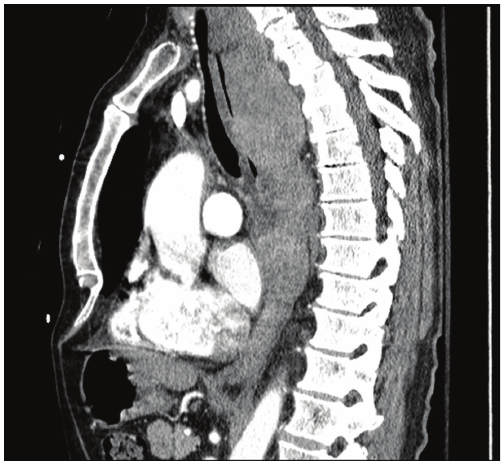
Figure 2: Sagittal view of a Posterior Mediastinal Hematoma measuring 5.9cm × 5.8cm × 21 cm, identified via CT scan upon patient presentation to